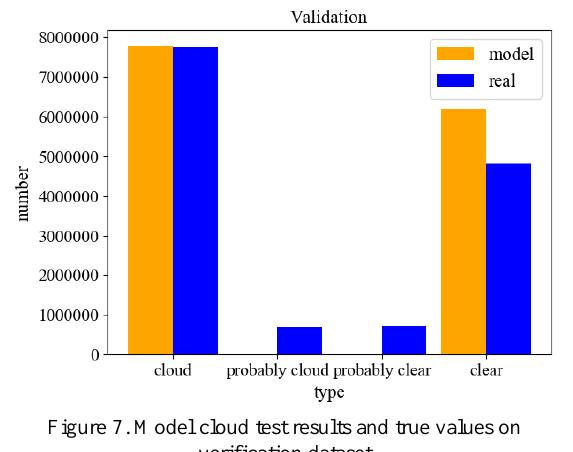
Figure 7. Model cloud test results and true values on